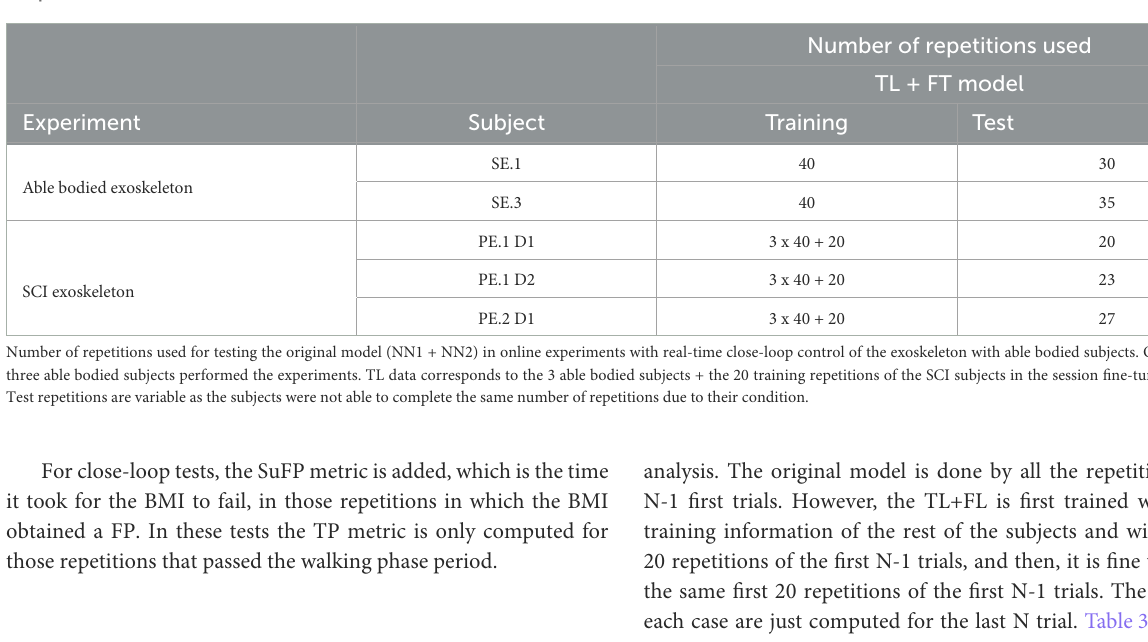
TABLE 4 Number of repetitions used by the BMI during its testing for the exoskeleton close-loop experiments with two able bodied subjects and two SCI